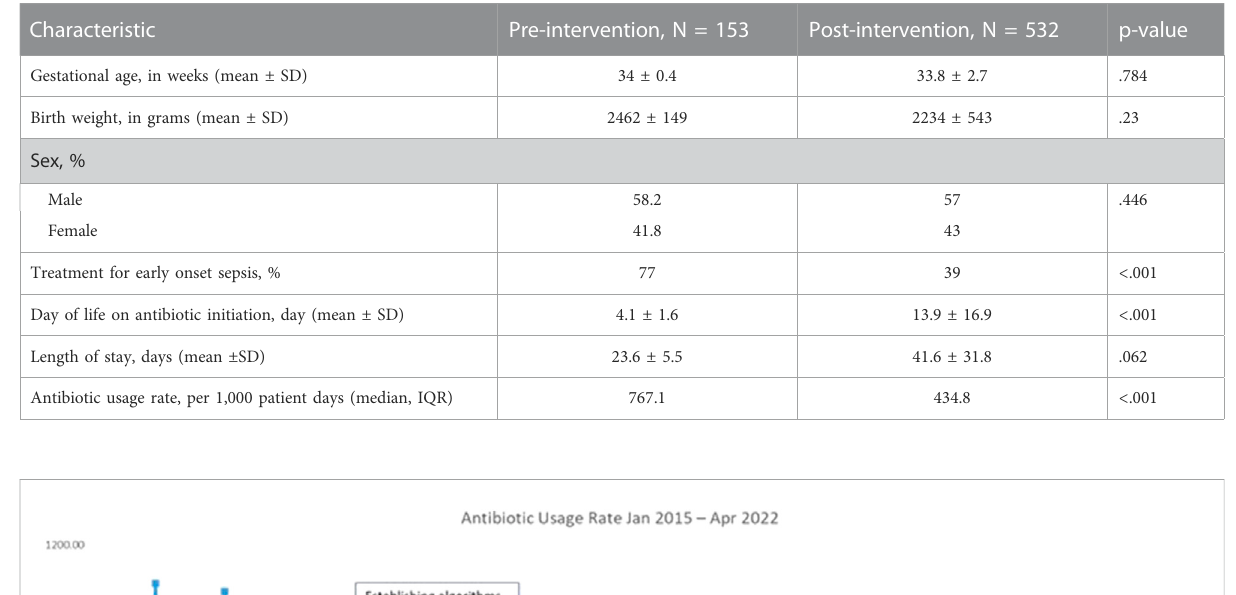
TABLE 1 Patient characteristics during the two periods of the study.